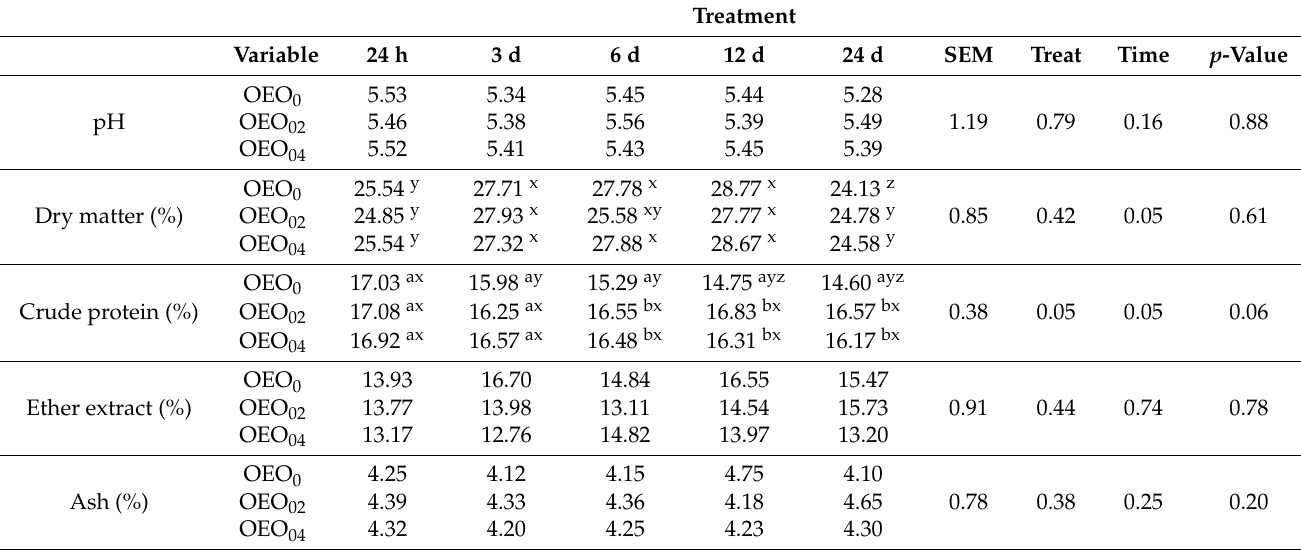
Table 5. Chemical composition of meat from lambs fed with different OEO levels in the diet.